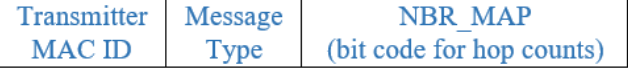
Figure 2. Format of neighbor discovery